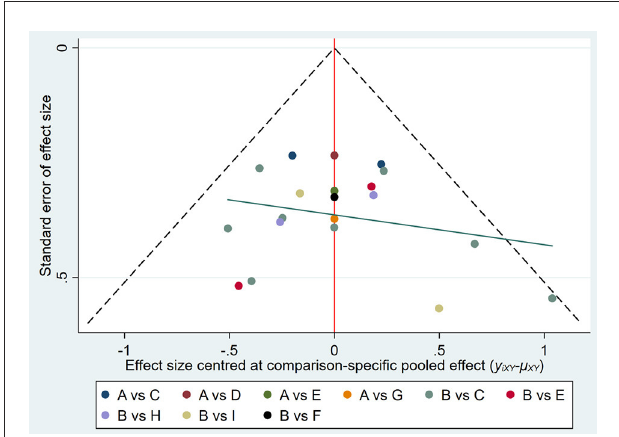
FIGURE7 Funnel plot of publication bias of included studies. A, CT; B, sham; C, 20min + 1mA anodal; D, 20min + 1.2mA anodal; E, 20min + 1.4mA anodal; F, 20min + 1.5mA anodal; G, 20min + 1.6mA anodal; H, 20min + 2mA anodal; I, 30min + 2mA anodal.